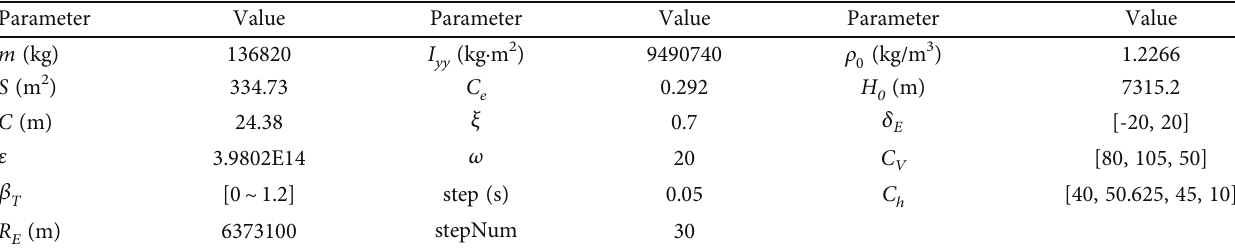
Figure 2: Trajectory tracking control system based on the predictive sliding mode Table 1: Some default parameters used in this paper.